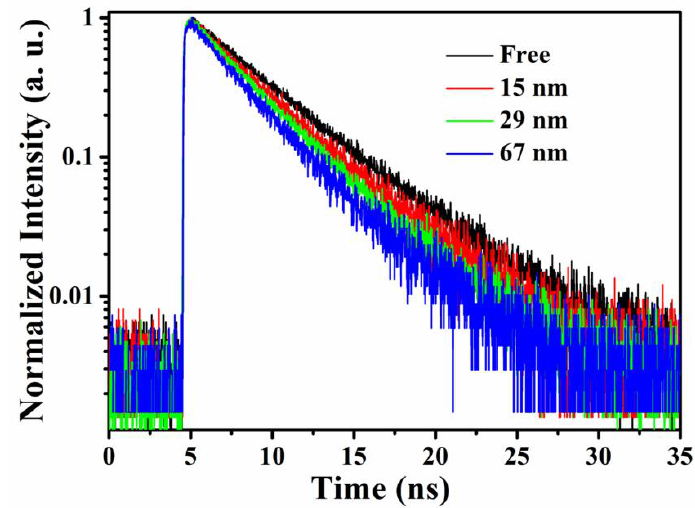
Figure 5 . Time-resolved fluorescence of iLOV mixed with differently sized Ag nanoparticles (140 uL). Figure 5. Time-resolved fluorescence of iLOV mixed with di ff erently sized Ag nanoparticles (140